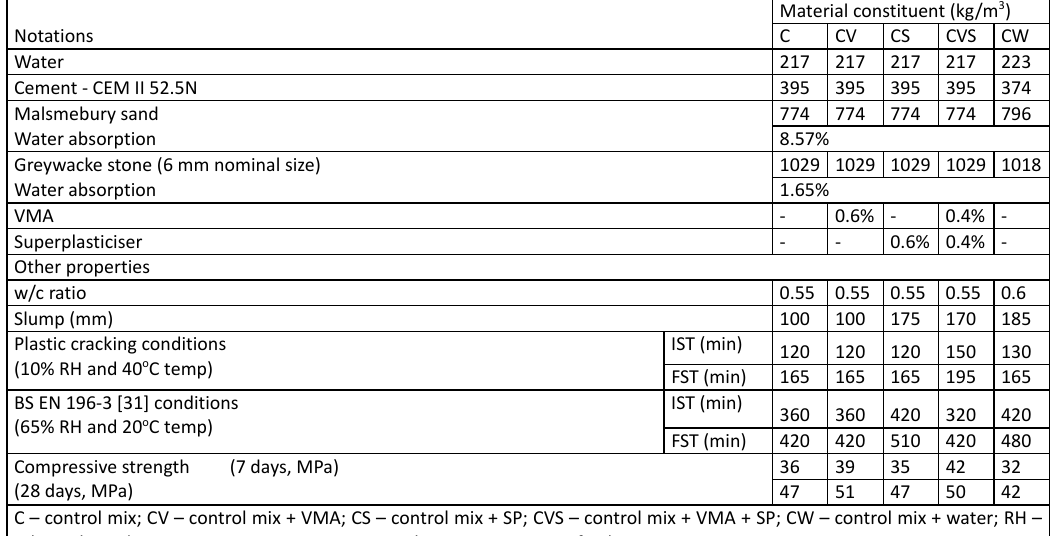
Table 1. Mix proportions and properties of the concrete mixes.